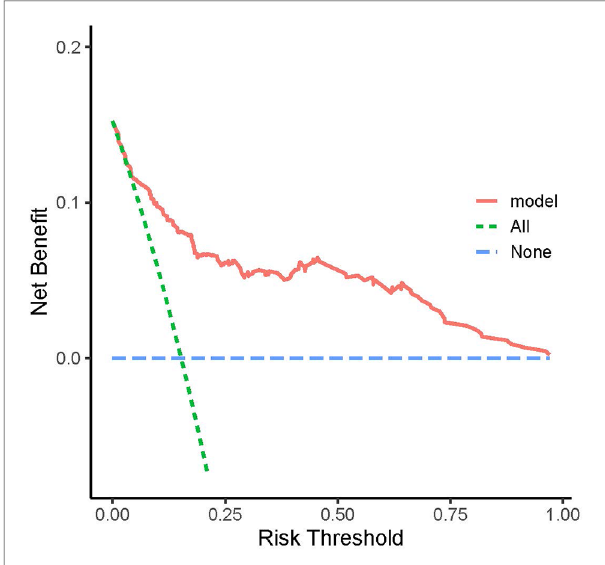
FIGURE 2 Decision curve analysis (DCA). The model was assessed for clinical utility using decision curve analysis